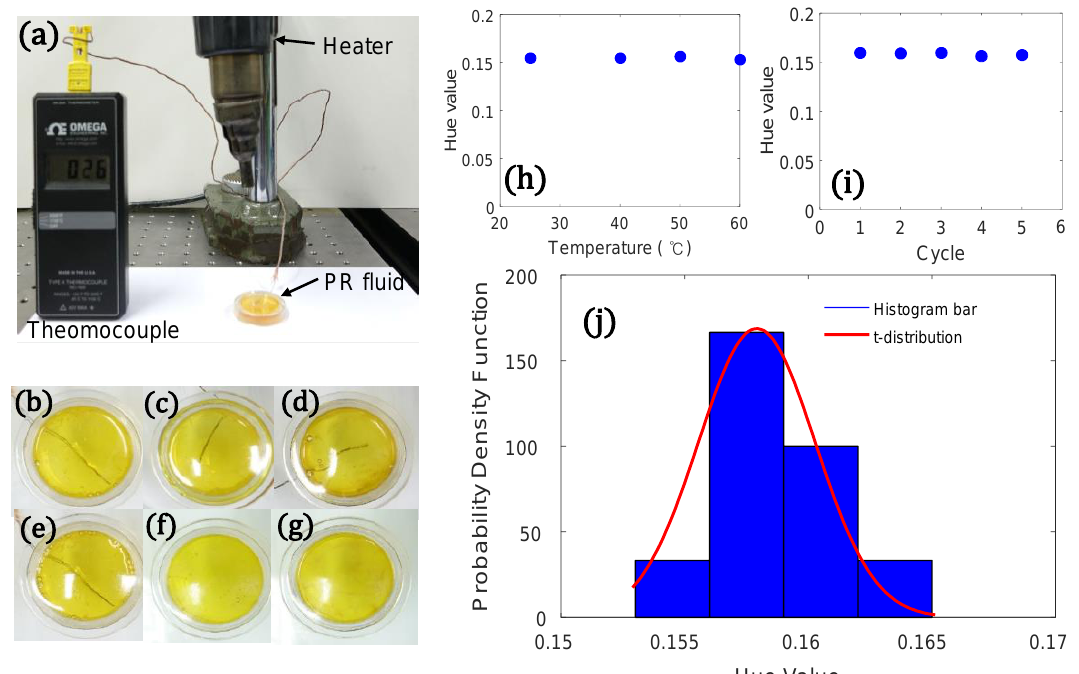
Figure 10. The repeatability and the effect of the temperature: ( a ) photograph of the experimental setup, ( b ) 25 ◦ C, ( c ) 40 ◦ C, ( d ) 50 ◦ C, ( e ) 60 ◦ C, ( f ) initial state at 25 ◦ C, ( g ) recovered state after five cycles, ( h ) hue value in response to different temperatures, ( i ) hue values versus cycle, ( j ) fitted student’s t -distribution of hue values.